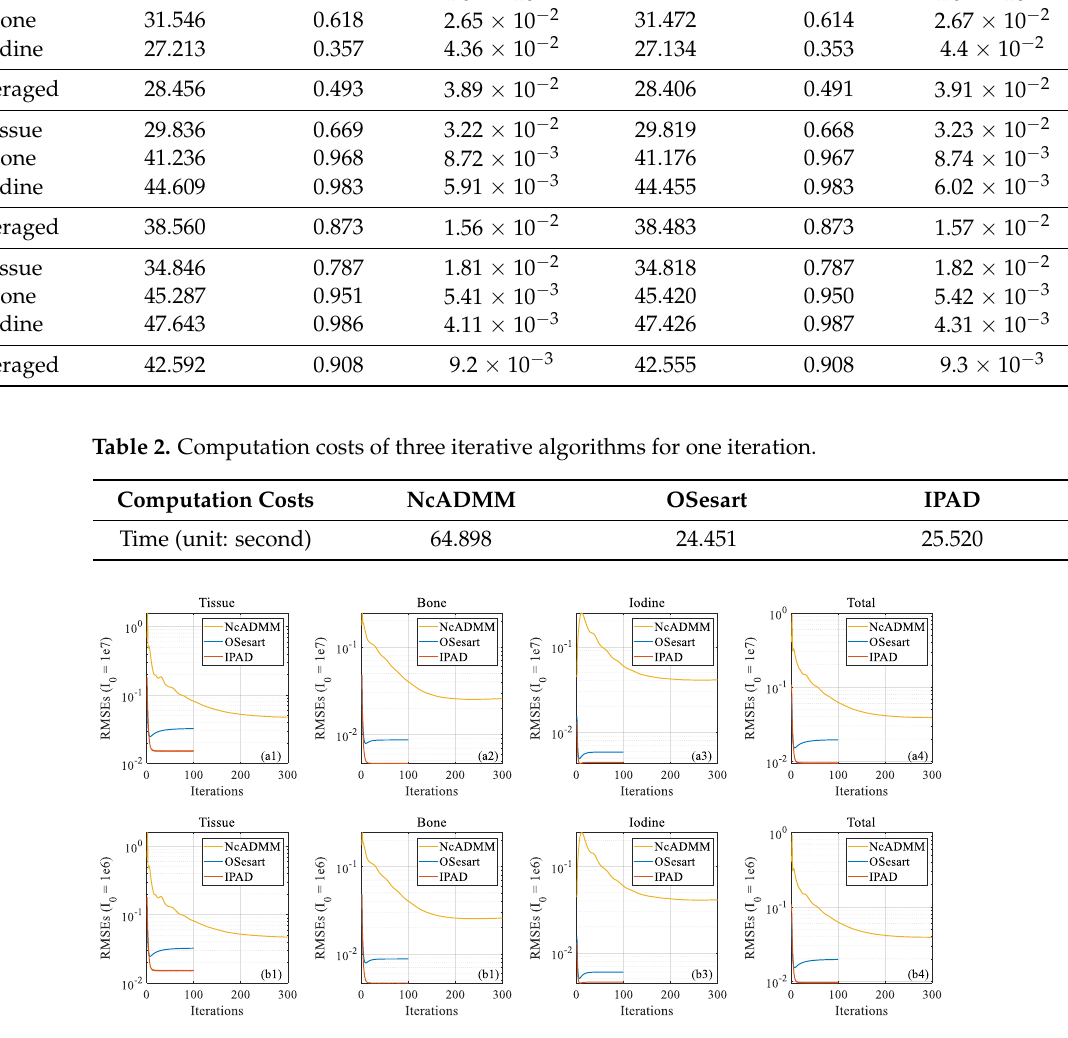
Figure 9. Profiles of different methods at different noise levels. ( a1 ) – ( a3 ), and ( b1 ) – ( b3 ) represent the profiles of tissue, bone, and iodine of different methods at two noise levels. 3.3. Thorax Dataset Verification The thorax dataset (https://www.ircad.fr/research/data-sets/respiratory-cycle-3d-ir- cadb-02/,accessed on 1 July 2018); downloaded to verify the performance of the algorithm in clinical experiments (The dataset is publicly available, and no ethical statements are involved). The public dataset contains 167 slices in total. We extract the 160th slice to im- plement our method with a more complex phantom. The selected slice is segmented into three components by the labels given in the dataset, i.e., tissue, bone, and lungs, where the lungs are supposedly injected with iodine and the concentration of iodine is set at 15 mg/mL. The corresponding attenuation coefficients of the three basis materials are ob- tained by NIST. Then, the projections are determined by the forward transmission model (4) with three energy bins. Similar to the simulation, the spectrum is derived from a tube voltage of 120 kVp and a 12 mm aluminum filter, and the three energy windows are sep- arated by the thresholds 30, 56, and 70 keV, respectively. The distances of the source to